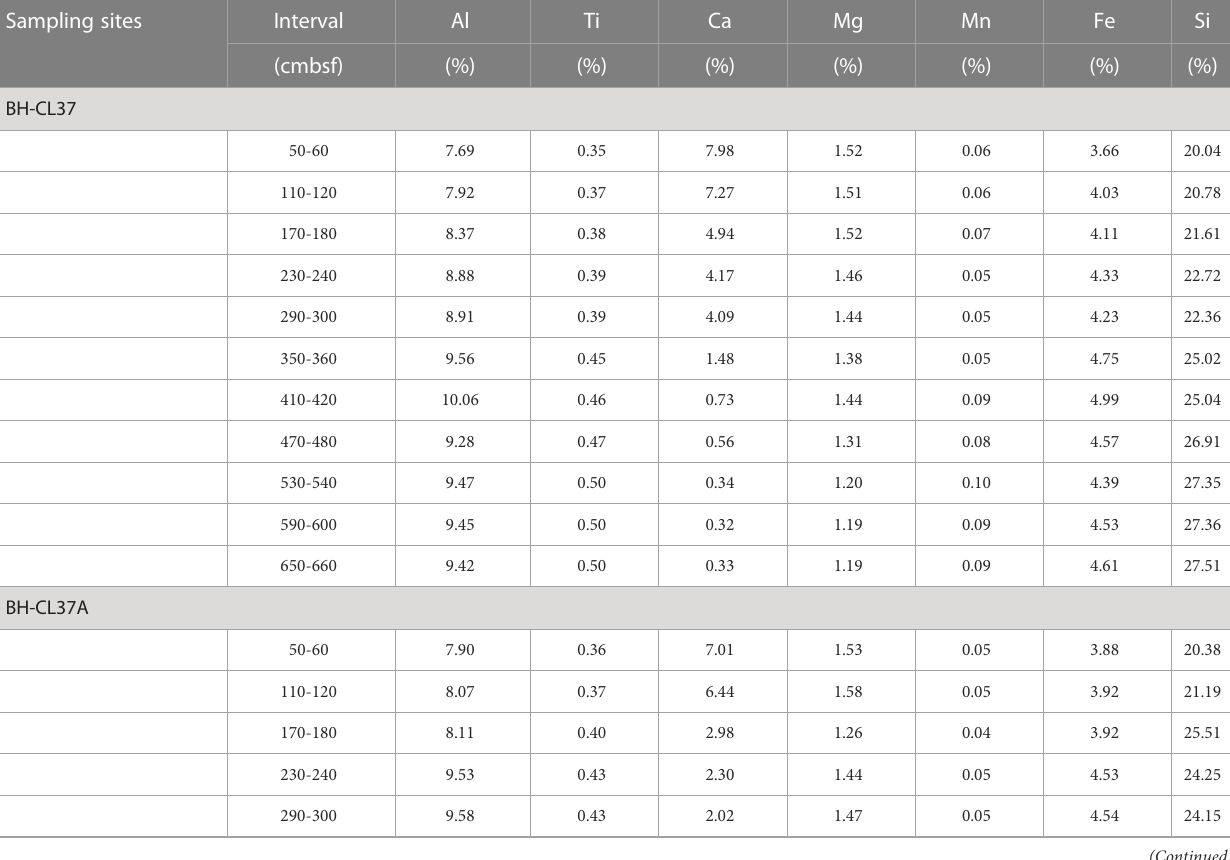
TABLE 3 Concentration of some major elements in